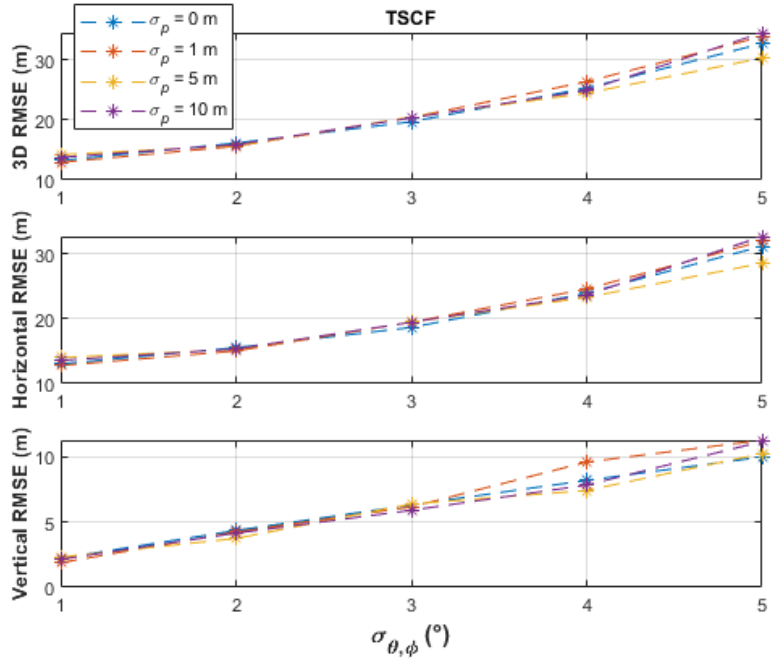
Figure 6. Performance comparison of the TSCF batch-processing solution under different levels of UAS position uncertainties and using 101 measurement points.